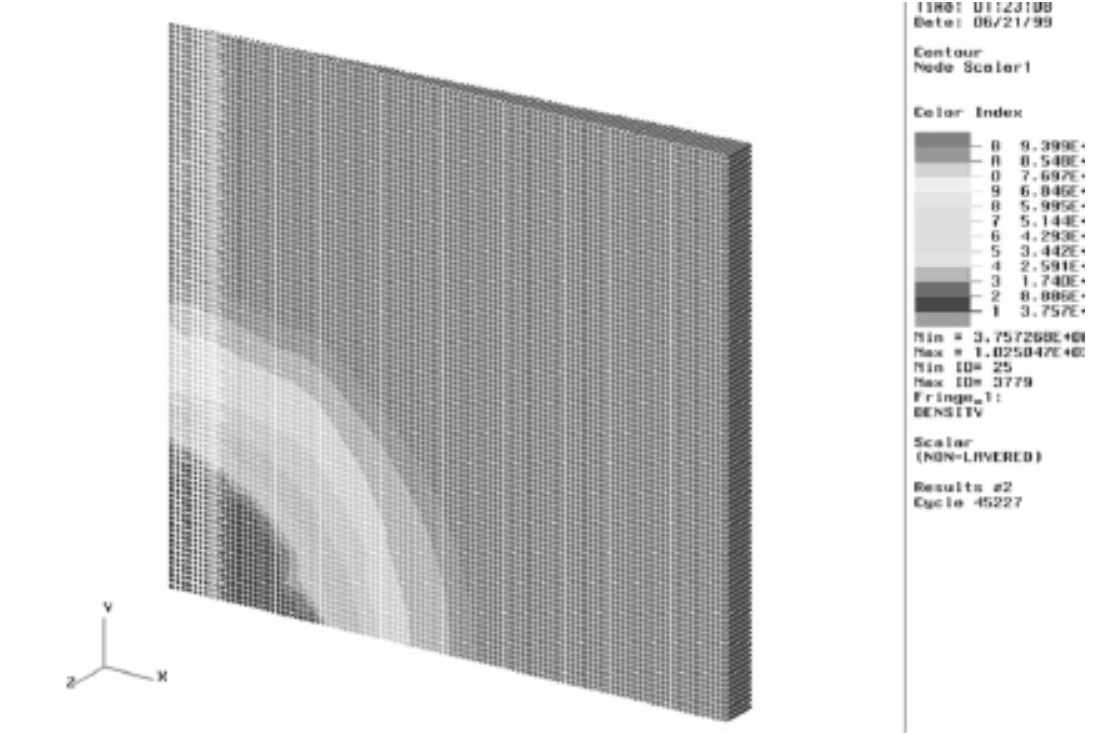
Fig. 11. Modeling of shock input loading using JWL equations (after time of 8 msec).